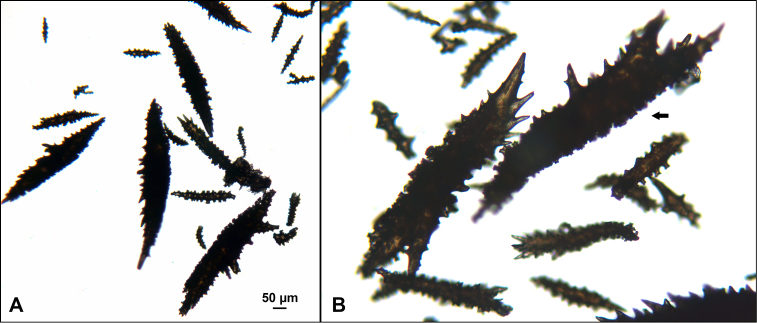
Muriceafruticosa, SBMNH 265945, light microscopy arrays. A 4× magnification, showing large spindles with pronounced conical spinules; central, vertically aligned one, measures 650 µm B 10× magnification of similar large spindles. Sclerite denoted by arrow is 0.875 mm in length, with a maximum length for this spindle form ~1.0 mm.